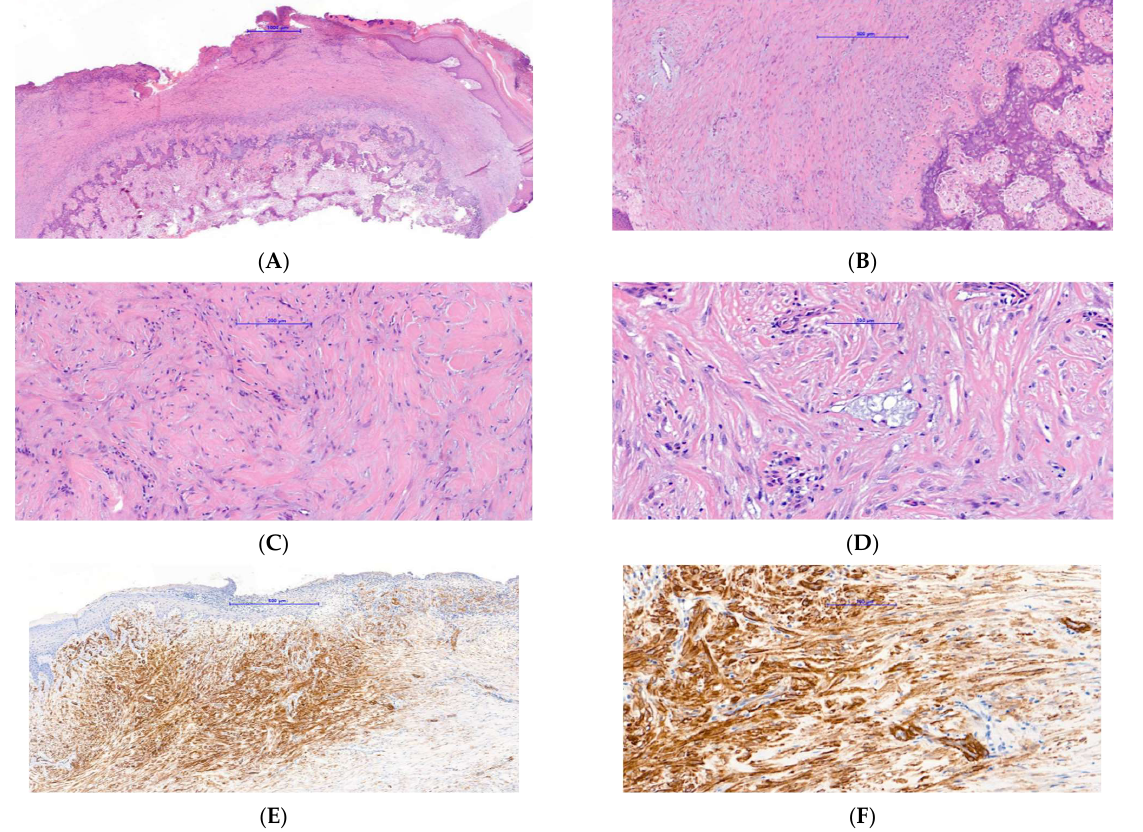
Figure 3. Histopathology of case 1: ( A ) low power image showing an ulcerated spindle cell pro- liferation overlying cartilage and bone. ( B ) Medium power image showing intimate relationship of spindle cell proliferation with underlying cartilage and bone. ( C ) High power image of spindle cell proliferation demonstrating a myofibroblastic morphology associated with myxoid stroma and focal keloidal-like collagen. ( D ) High power image highlighting focal microcysts of myxoid stroma reminiscent of those seen in nodular fasciitis. ( E , F ) low and high power images, respectively, of immunohistochemistry for SMA, showing strong positivity of the spindle cell proliferation with a “tram track” pattern of staining fully in keeping with a myofibroblastic phenotype.